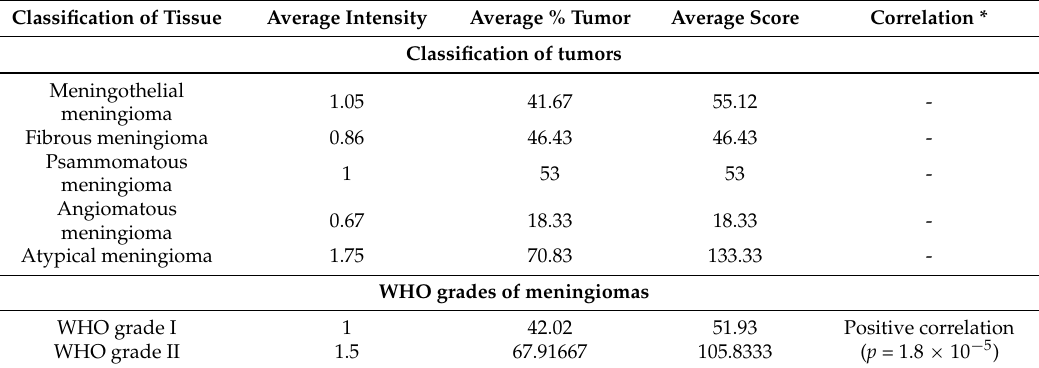
Table 3. The intensity of Nrf2 immunostain scores and clinicopatholigcal parameters of meningiomas. Classification of Tissue